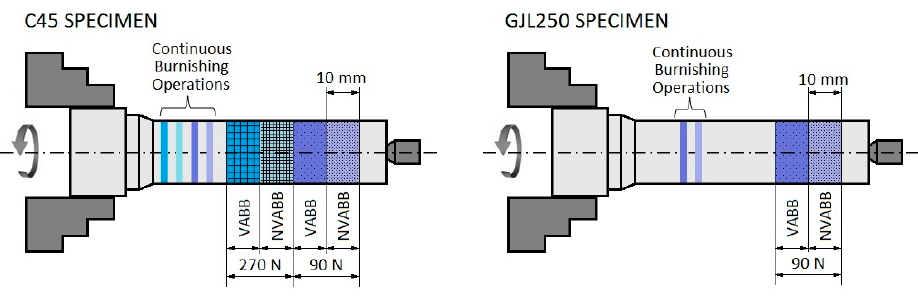
Figure 5. Burnishing test areas.